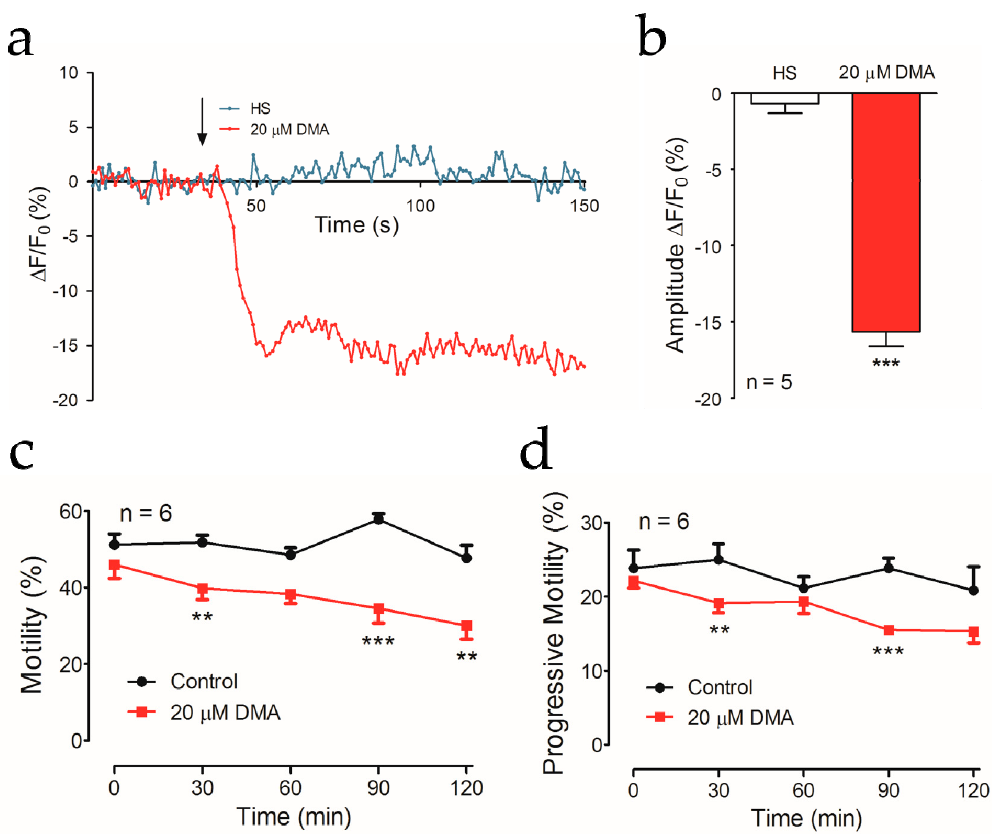
Figure 5. The effect of NHEs inhibition by DMA on intracellular Ca 2+ and motility of mouse sperm were evaluated. ( a ) The fluorescence trace of intracellular Ca 2+ signals was shown. Arrow indicates the time point of HS solution or DMA injection. ( b ) Mean fluorescence intensities of Ca 2+ signals in the absence and presence of DMA. n = 5 (*** p < 0.001, paired t -test). The effect of DMA on the total motility ( c ) or the progressive motility ( d ) of mouse sperm at 0, 30, 60, 90, and 120 min was shown. Data are expressed as mean ± SEM. n = 6 (** p < 0.01; *** p < 0.001, unpaired t -test).